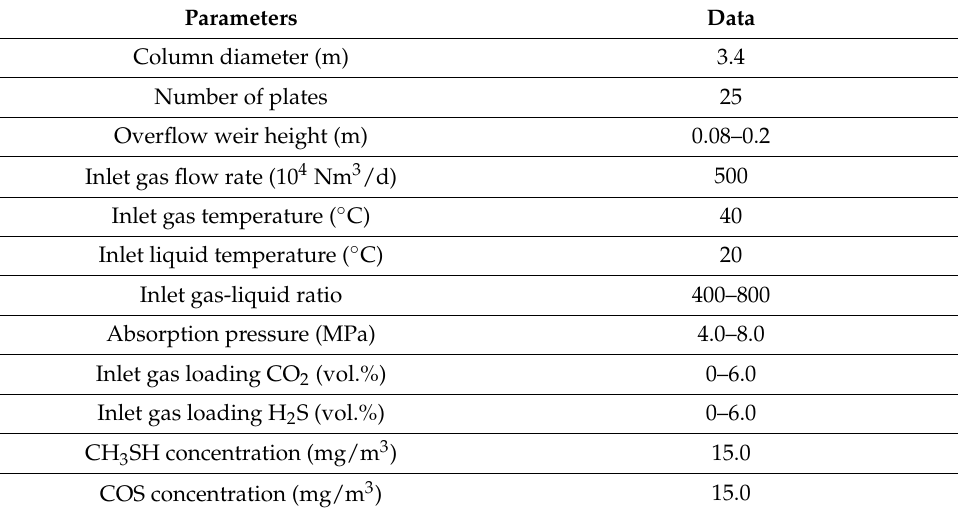
Table 4. Specifications of the absorber column and typical operating data.